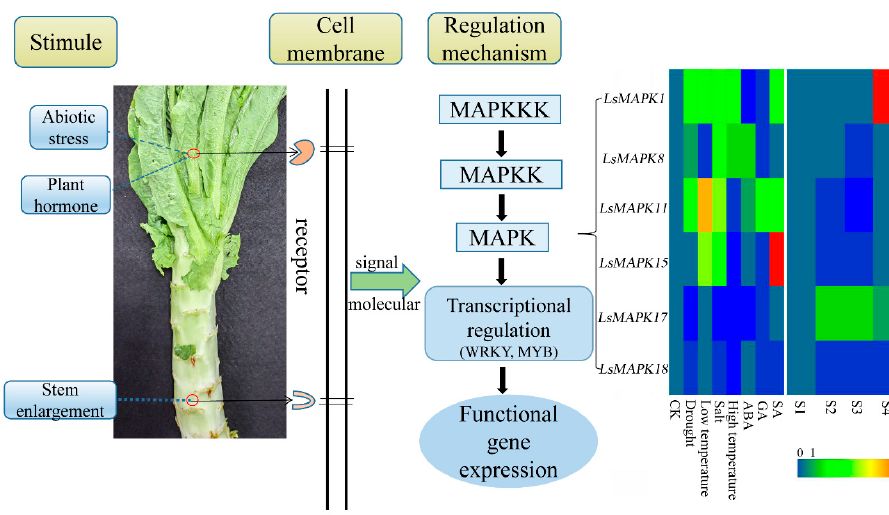
Figure 12. Possible model of stem lettuce LsMAPK genes involved in different